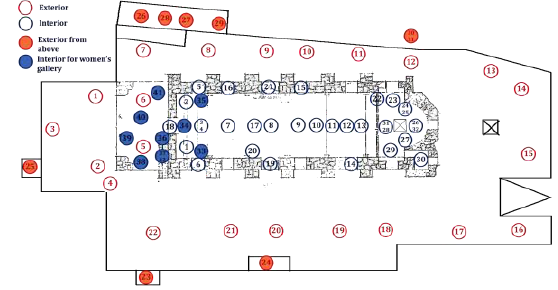
Figure 3. Iposcopic plan with the nave frescoes orthoimage